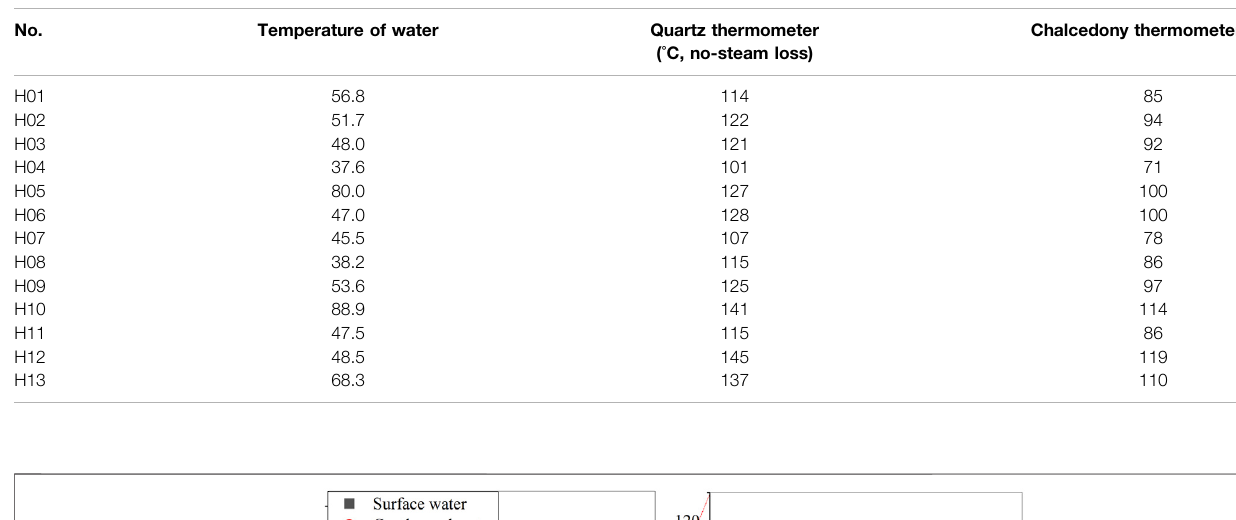
TABLE 4 | Estimated temperatures of geothermal reservoirs in Xiamen.